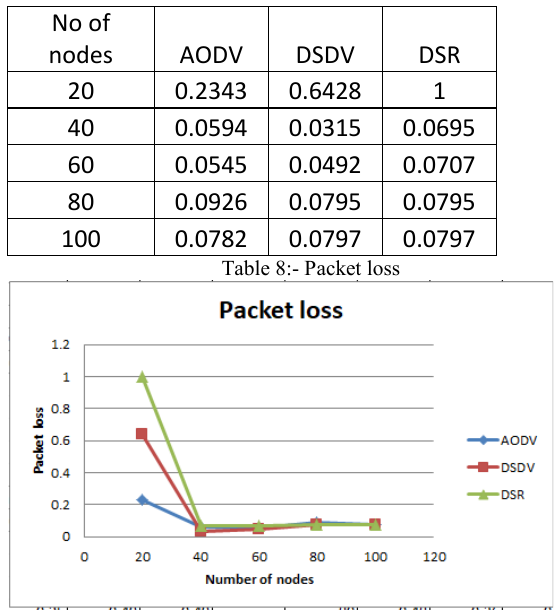
Table5:- Packet delivery Ratio